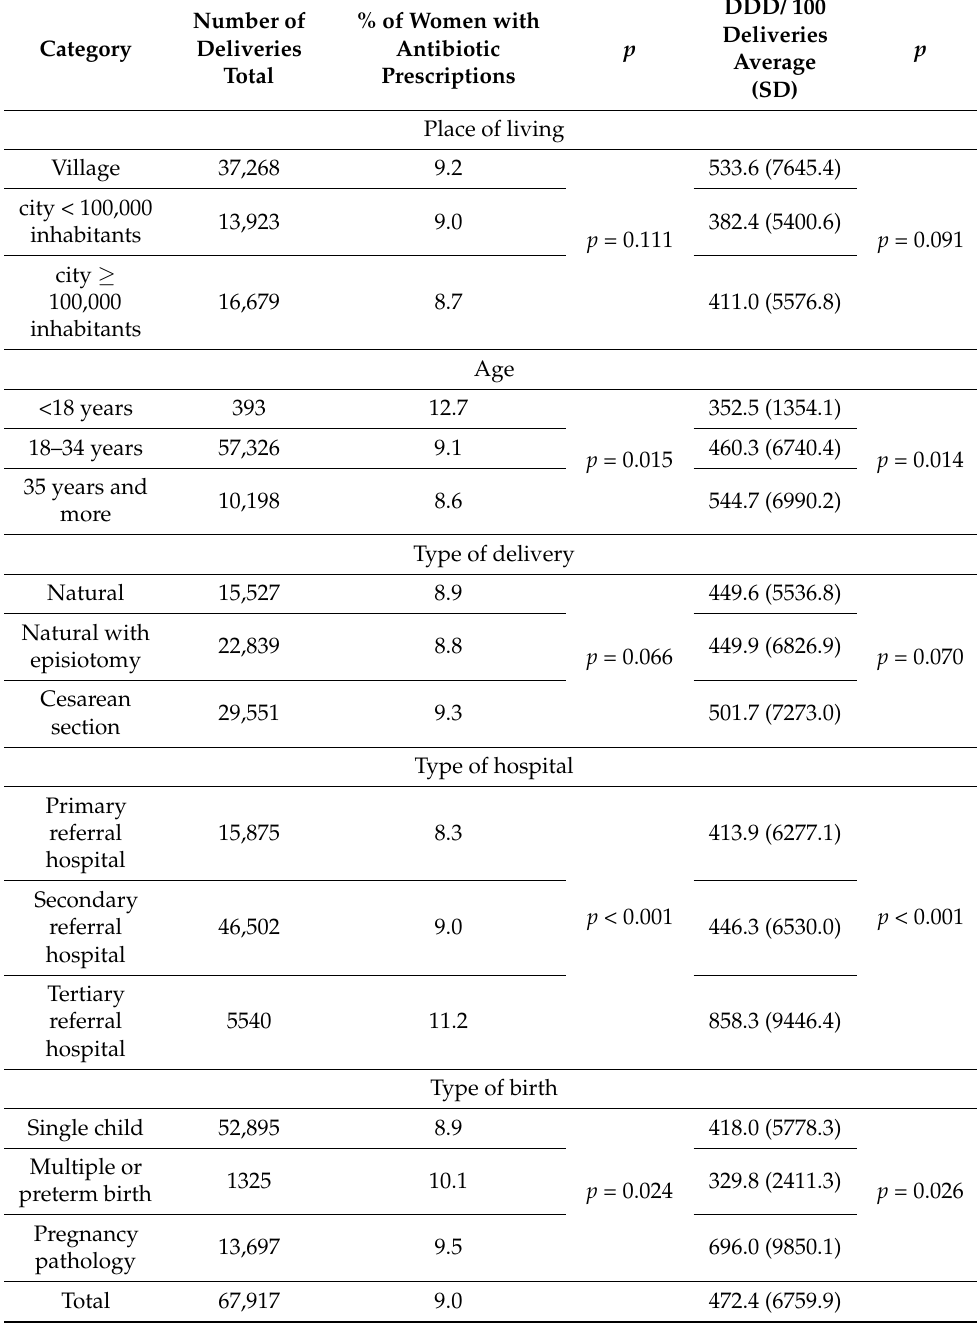
Table 4. Number of prescriptions and DDD for the second trimester according to place of living, hospital type, women’s age, and type of